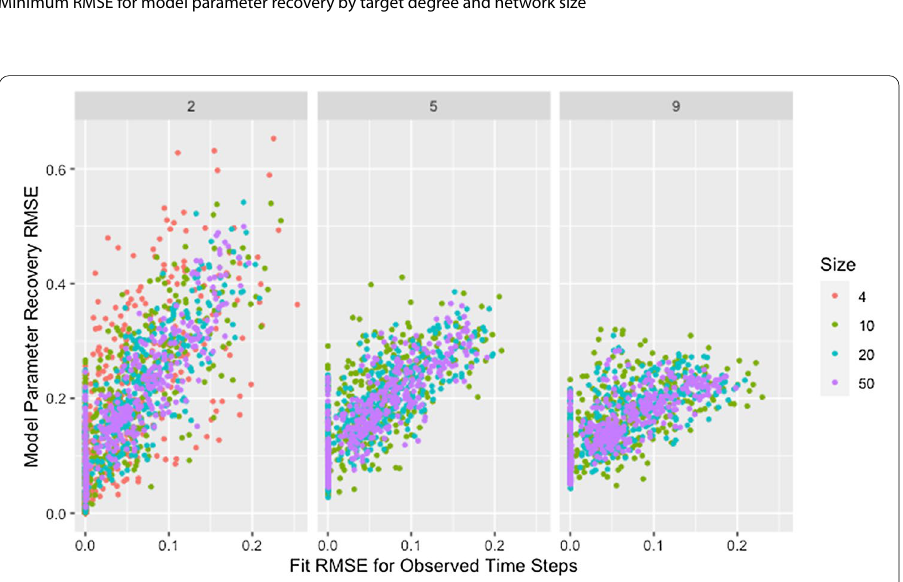
Minimum RMSE for model parameter recovery by target degree and network size